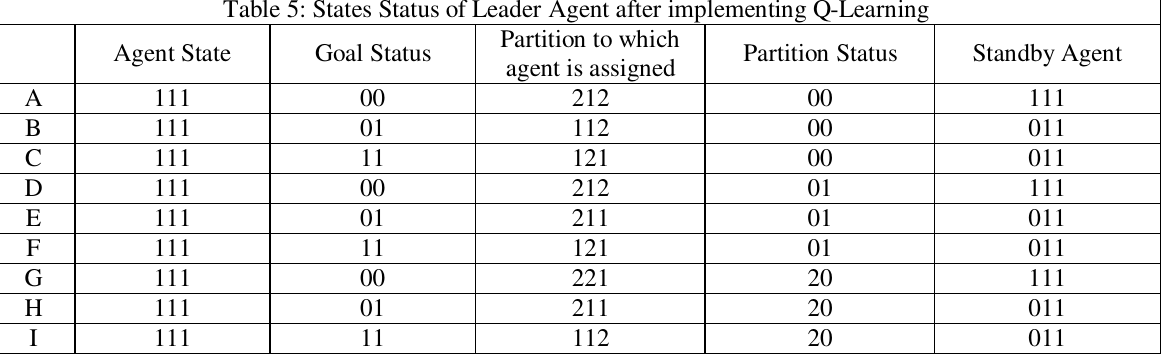
Fig. 7: Case C of Agents Movement Table 5: States Status of Leader Agent after implementing